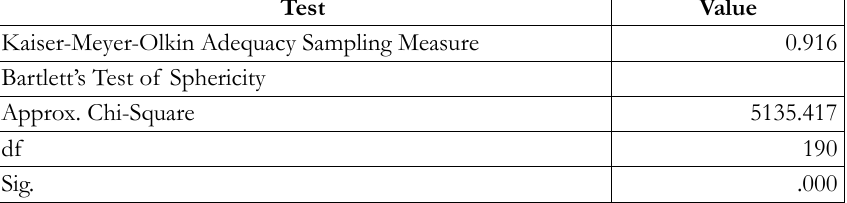
Table 2. Kaiser–Meyer–Olkin (KMO) and Bartlett’s test.